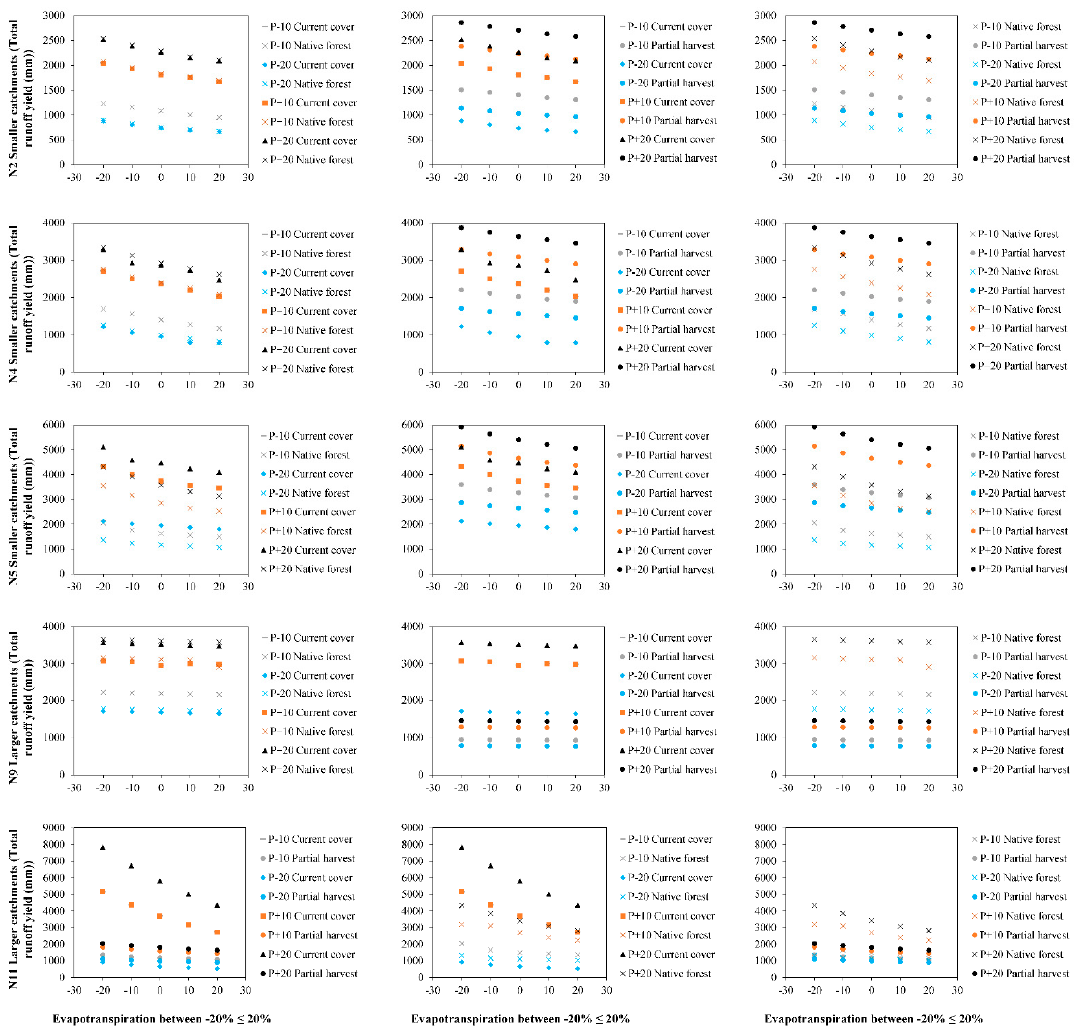
Figure 5. Runoff yield associated with different climate scenarios and land uses for the different catchments under study (i.e., Additional supporting information on all catchments can be found online in the Supporting Information section at the end of the paper, Figure S4).